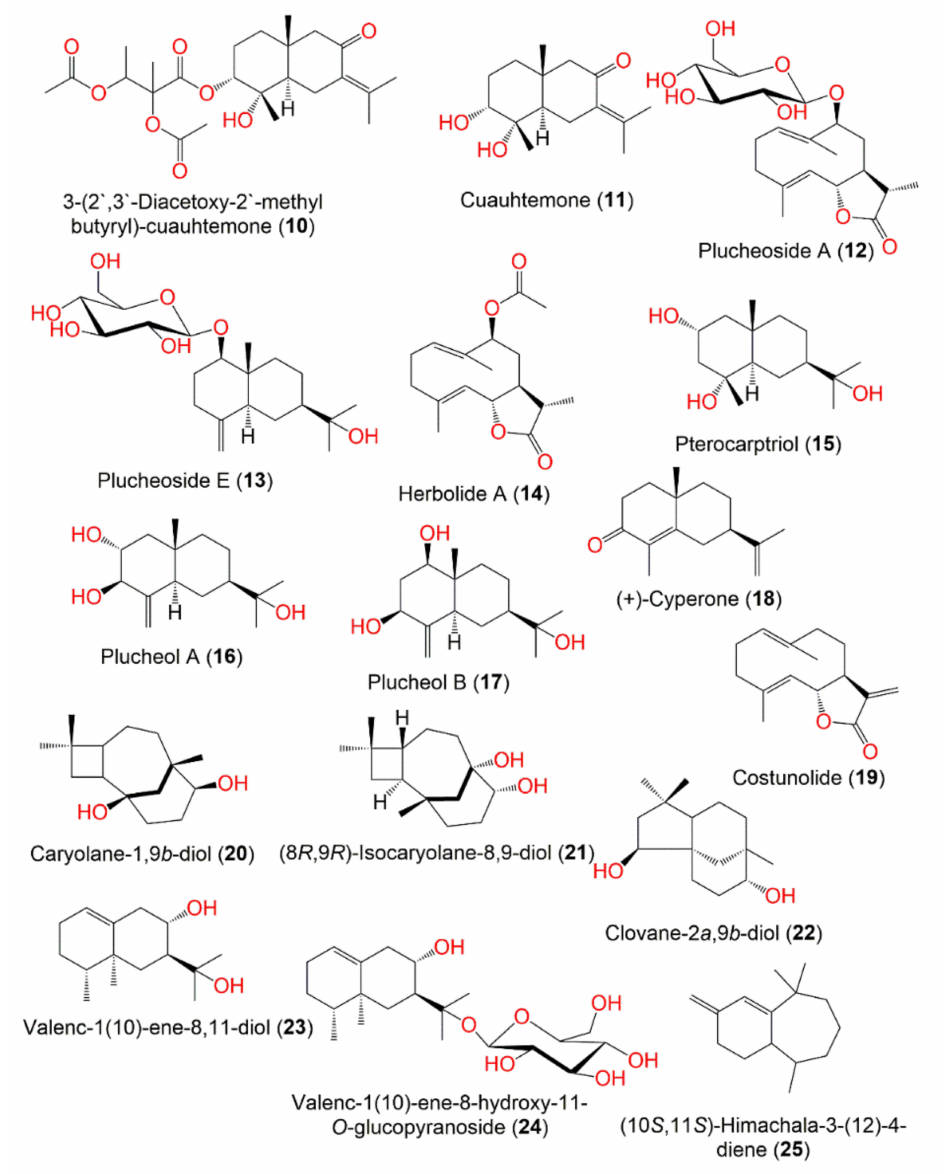
Figure 2. Structures of compounds 10 – 25